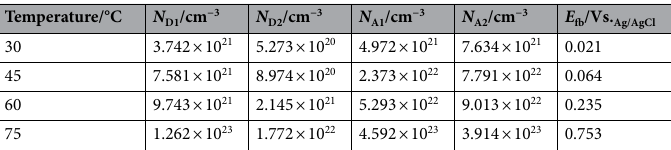
Temperature/°C N D1 /cm −3 N D2 /cm